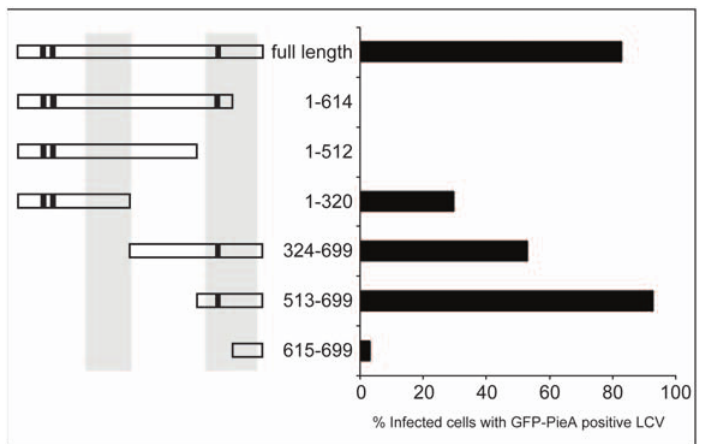
Figure 5. Deletion analysis of the PieA protein reveals a C-terminal domain sufficient for the recruitment of PieA to vacuoles containing L.pneumophila . CHO Fc c RII cells transiently expressing the indicated PieA deletion constructs N-terminally fused to GFP were infected with wild-type L. pneumophila . Cells were fixed seven hours post infection and scored for the percent of PieA-expressing infected cells where PieA was detected decorating vacuoles containing L. pneumophila . Values are means from two independent experiments in which 30 vacuoles were scored for each condition. A schematic illustration of the PieA protein sequence shows the different truncation constructs, as well as the predicted coiled-coil domains (black bars) and the identified vacuole recruitment domain (VRD - grey bars). PieA C-terminal residues 513–699 were found to be sufficient for mediating the recruitment of the protein to vacuoles containing L. pneumophila .